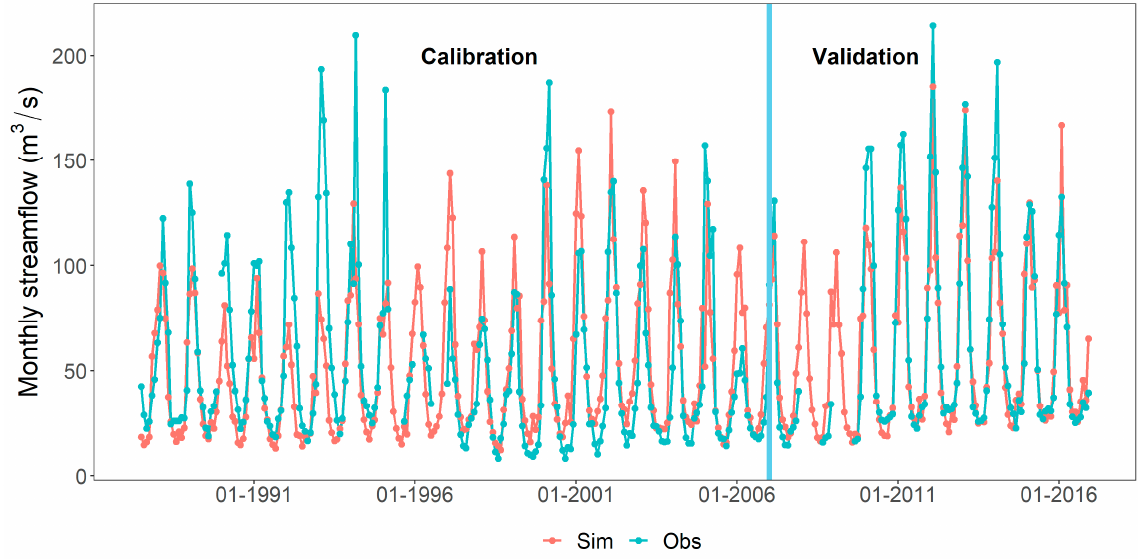
Figure 6. Monthly average of simulated and observed flow (1987–2016). Table 6. Values of simulated (Qs) and observed (Qo) average flow metrics.